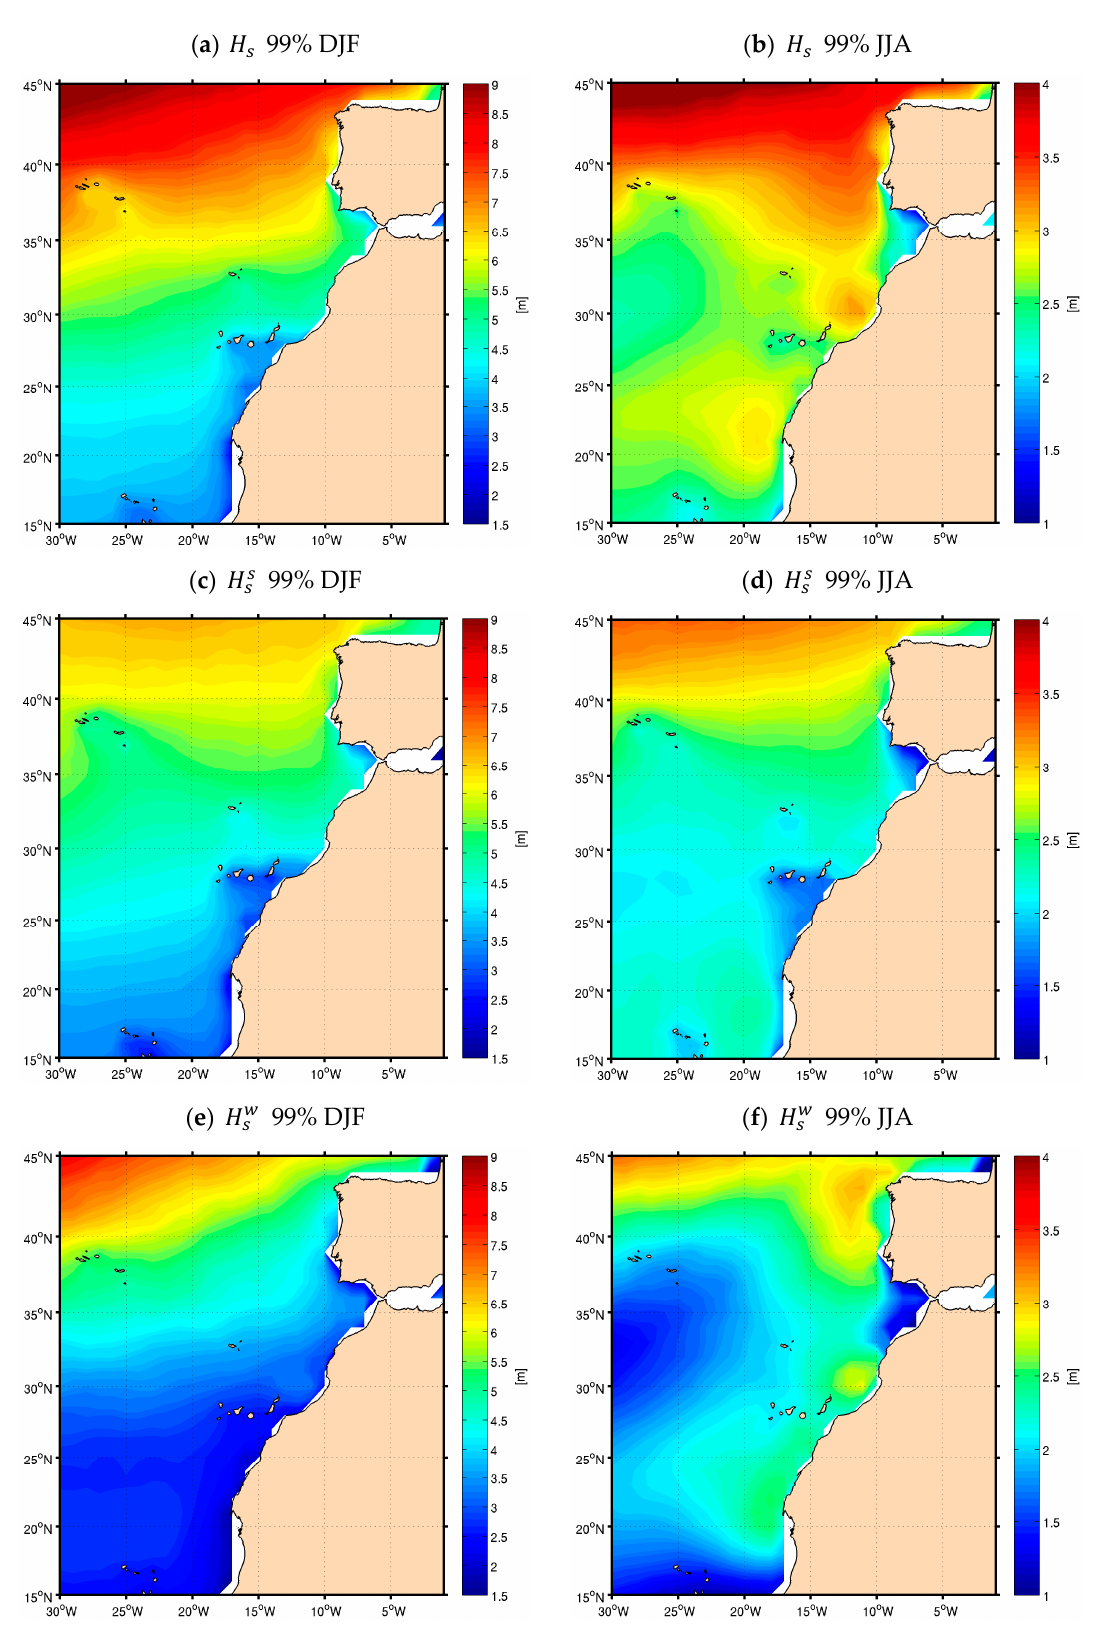
Figure 5. Climatological averages of the 99% percentiles of H s (m) for ( a ) DJF and ( b ) JJA, of H s s (m) for ( c ) DJF and ( d ) JJA, and of H w s (m) for ( e ) DJF and ( f ) JJA. The color scales vary between